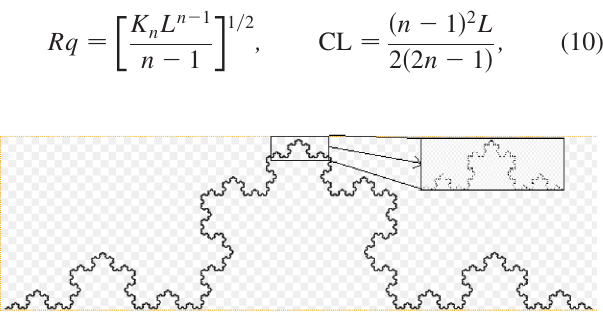
FIG. 9. Koch curve illustration of fractal structure [41].